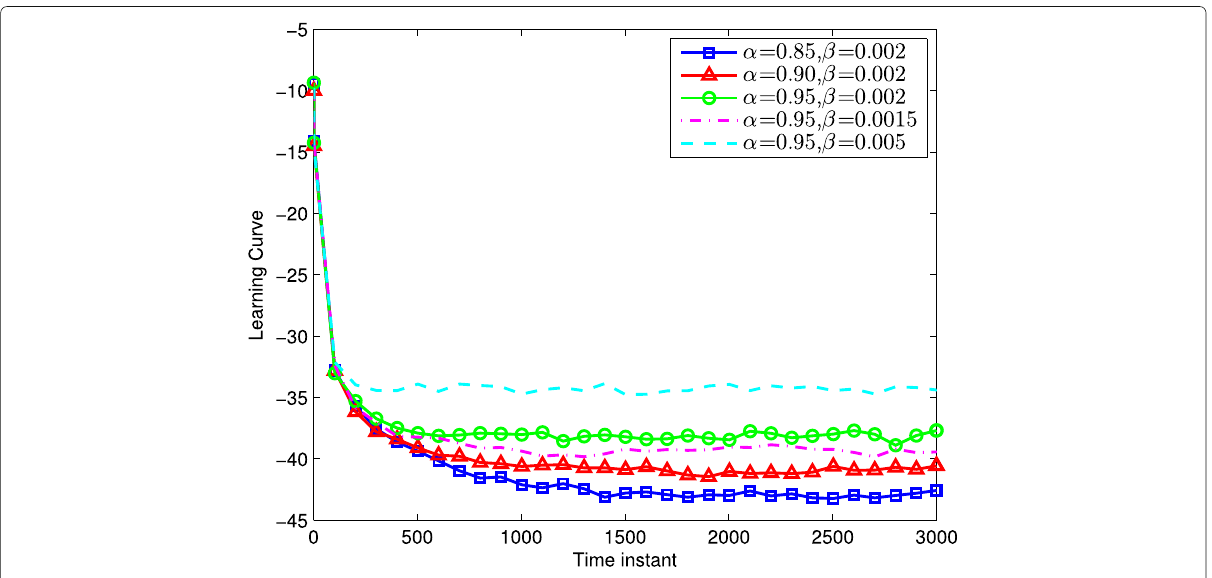
Fig. 6 Learning curves against different values of α and β for LTVFF-DRLS algorithm